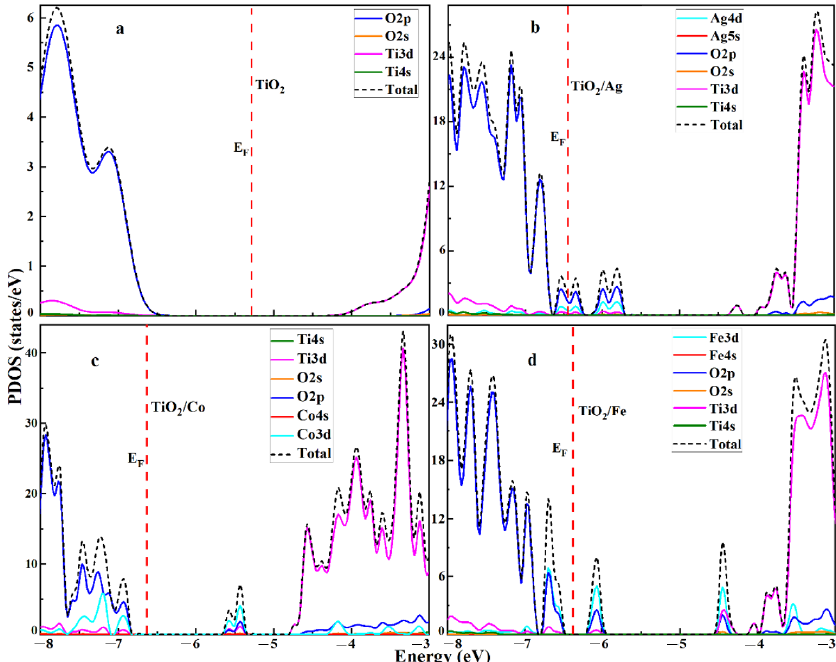
Figure 4. Projected density of states of ( a ) pristine and ( b ) Ag-, ( c ) Co-, and ( d ) Fe-doped TiO 2 . The generation of H 2 via water splitting has been of great importance [46]. To induce